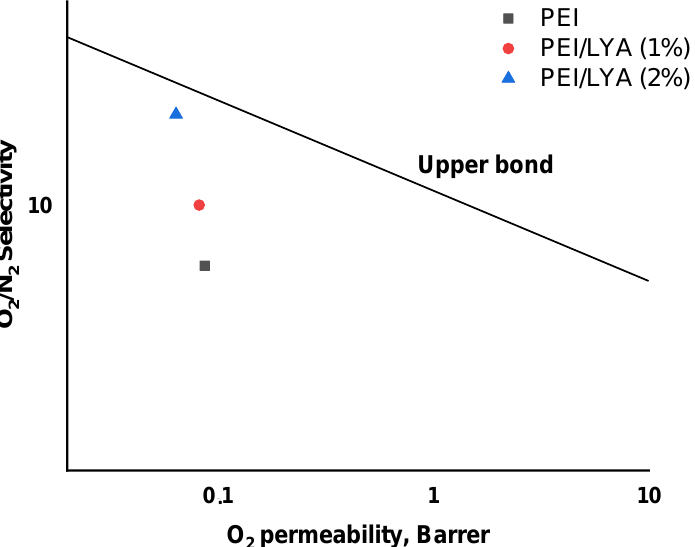
Figure 15. Permselectivity vs. permeability diagram for O 2 /N 2 gas pairs. The upper bound line was taken from the Robeson diagram [45].